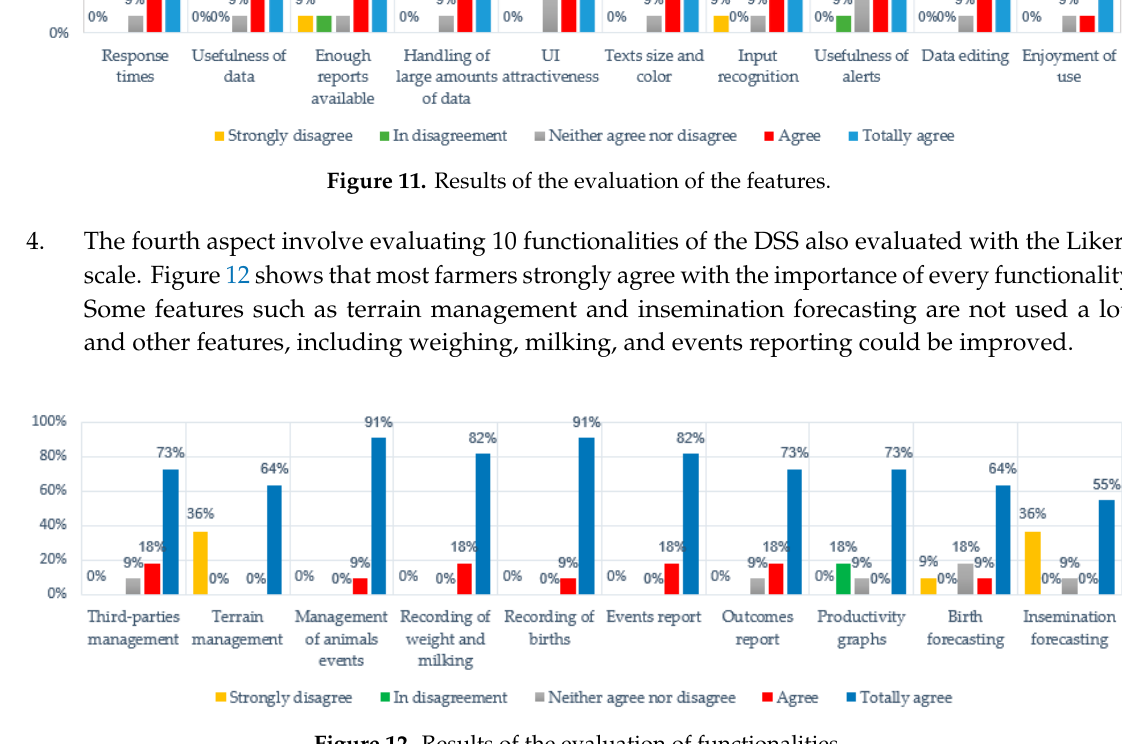
Figure 13. Reasons for abandoning the strategy 4. Discussion IT adoption is defined as the involvement of IT tools in processes to solve the need for information to improve the way the processes are run [21]. IT appropriation goes further than involving the tools, as it also means that these tools are used autonomously and with personal involvement [25]. Based on these definitions, the authors recognize that the proposed strategy for the rural sector achieved the appropriation of the DSS as it integrated tools, managed them to be used autonomously, and changed the way processes were executed. Small bovine production systems are organizations that must begin to take advantage of technology by following IT adoption despite the limitations of resources as [50] where an intervention is required for an adoption process to be viable. In this study the intervention is executed by a tutor who accompanies the training and builds the tools. The strategy included three IT tools with gamification elements and this helped to generate trust and involvement, which are especially important goals when training [51], in this case by senior adults. Both goals were achieved mainly because of the feedback that arose from the questions that the tutor or the farmer asked during the training regarding the obtained result. The strategy helped the farmers to become process transformers while collaborating on the construction of a simulation model that represented their productive systems. This is as mentioned by Lundström and Lindblom [52], who recommend researchers to take the context of the participants into account when designing training strategies on the use of DSS for the agricultural sector. The strategy follows what Somers and Stapleton [53] claim about IT appropriation being a challenge that needs to be tackled with strategies that improve the life conditions and benefit their